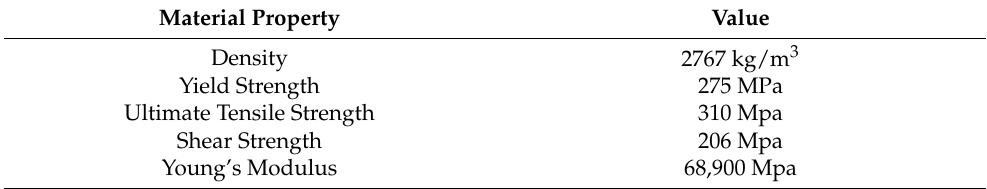
Table 2. Mechanical properties of 6061 T6 aluminum from Metal Supermarkets,